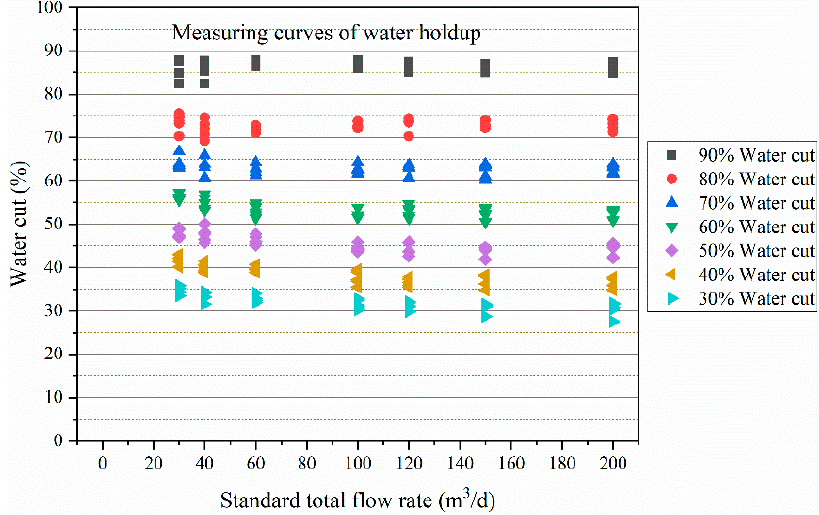
Figure 10. Water holdup measurement chart at five inclination